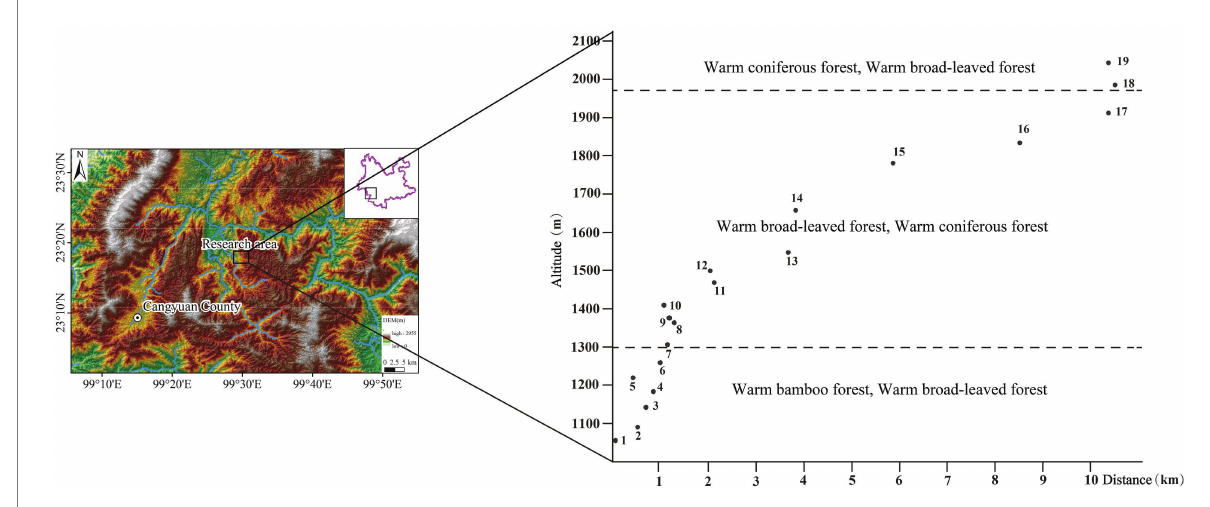
FIGURE 2 Geographical location of topsoil samples and vertical distribution of sampling